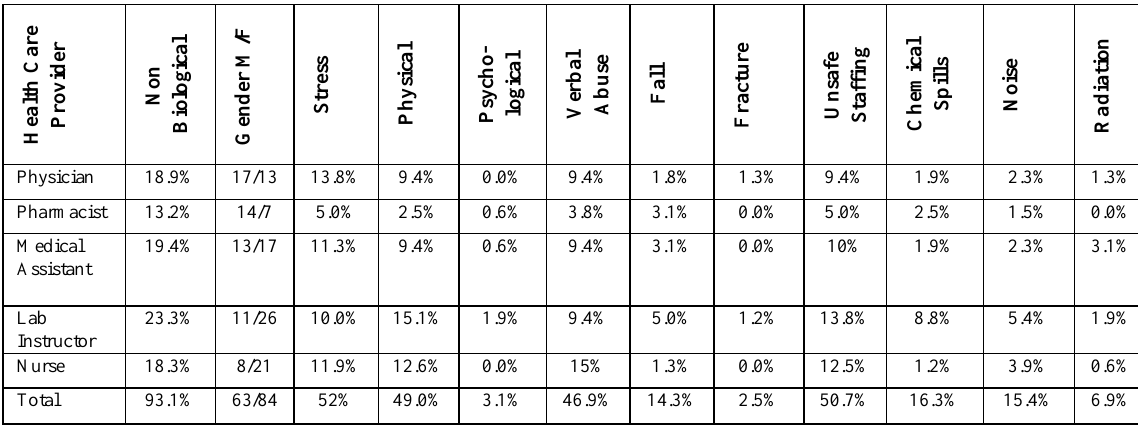
Table 4. Non-Biological Hazards in different Healthcare